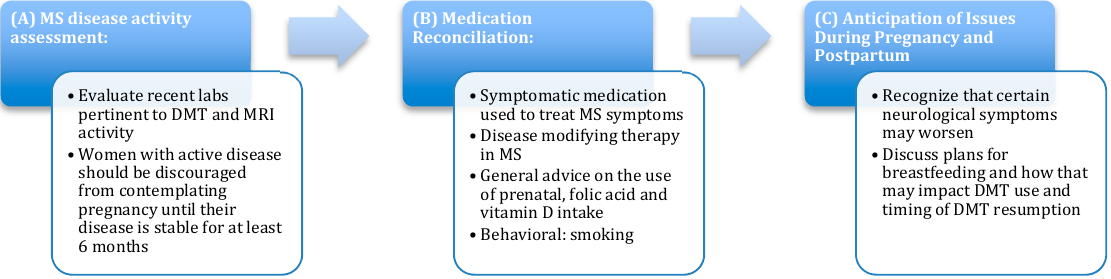
Figure 1. Pre-pregnancy care. ( A ) Multiple sclerosis (MS) disease activity assessment, ( B ) medication reconciliation, ( C ) anticipation of issues during pregnancy and post-partum.